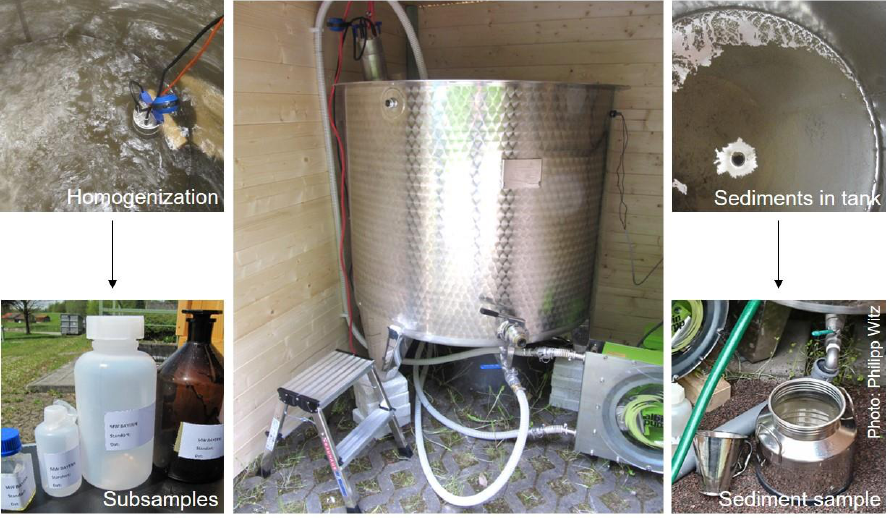
Figure 3. Photographs of the large-volume samplers and subsampling procedures used in this study.